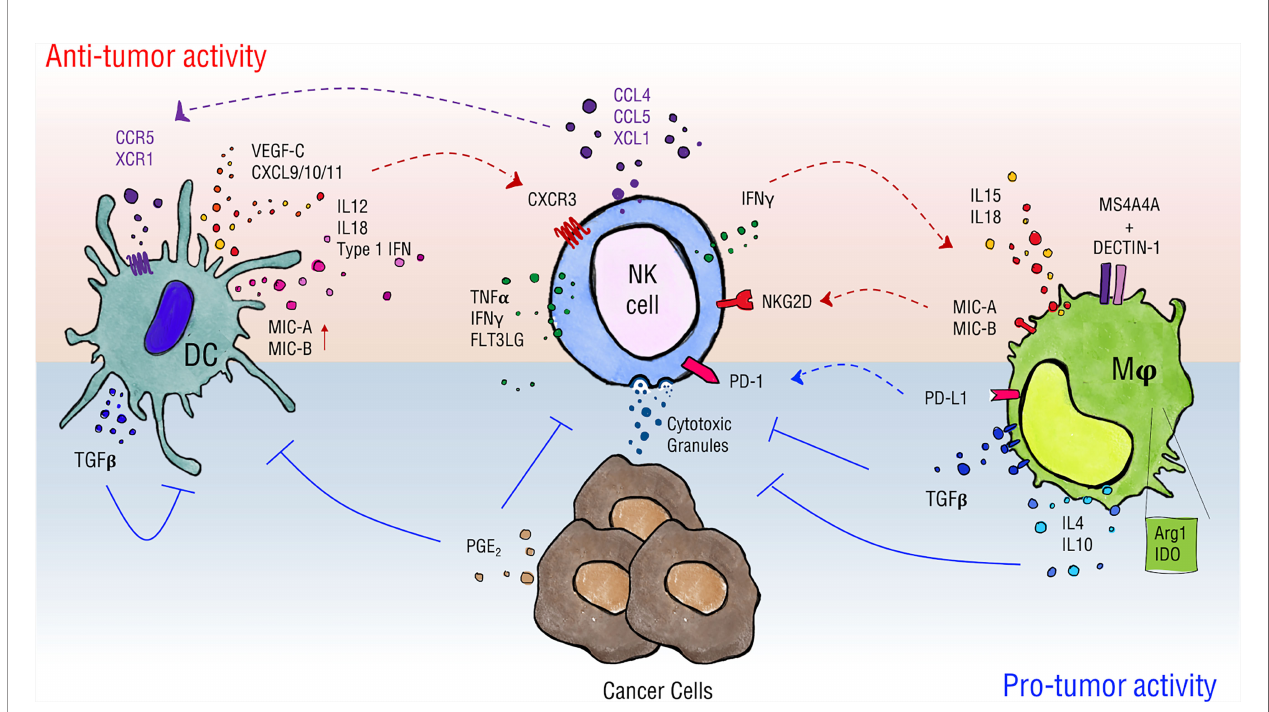
FIGURE 1 | Schematics of NK cell interactions with DCs and macrophages. Myeloid cells can have different impacts on NK cell activity in the tumor context. DCs favor NK cell recruitment by release of CXCL9/10/11 and promote their activity in terms of proliferation, cytokine production and cytotoxicity through release of type 1 IFNs, IL-12 and IL-18, and by the expression of NKG2D ligands MIC-A/B. NK cells, in turn, can regulate DC in fi ltration by intratumor secretion of chemotactic factors such as CCL4, CCL5, XCL1 and FLT3LG and stimulate their maturation through TNF a and IFN g secretion. In a similar way, macrophages release IL-15 and IL-18, and can express MIC-A/B when stimulated, thus supporting NK cell proper activation. Moreover, they can drive NK cell tumor cytotoxicity in a MS4A4A/ Dectin-1-mediated recognition of cancer cells. On the other hand, DCs upregulate expression of TGF- b upon interaction with NK cells thus establishing negative feedback on activation of both cells involved. Macrophages shape NK cells phenotype contributing to the establishment of an immune-suppressive environment via the production of soluble factors such as TGF- b , IL-4, IL-10 and the expression of enzymes as Arg1 and IDO and of PD-L1, the ligand for PD-1 checkpoint receptor. Ultimately, cancer cells produce PGE 2 that negatively affects DC and NK cell